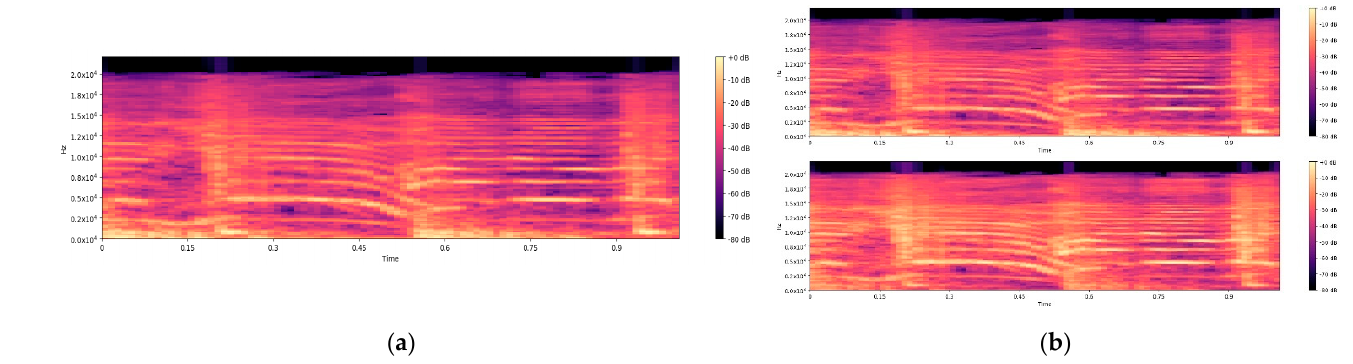
Figure 2. Audio spectrograms. ( a ) Real mono audio; ( b ) fake stereo audio.